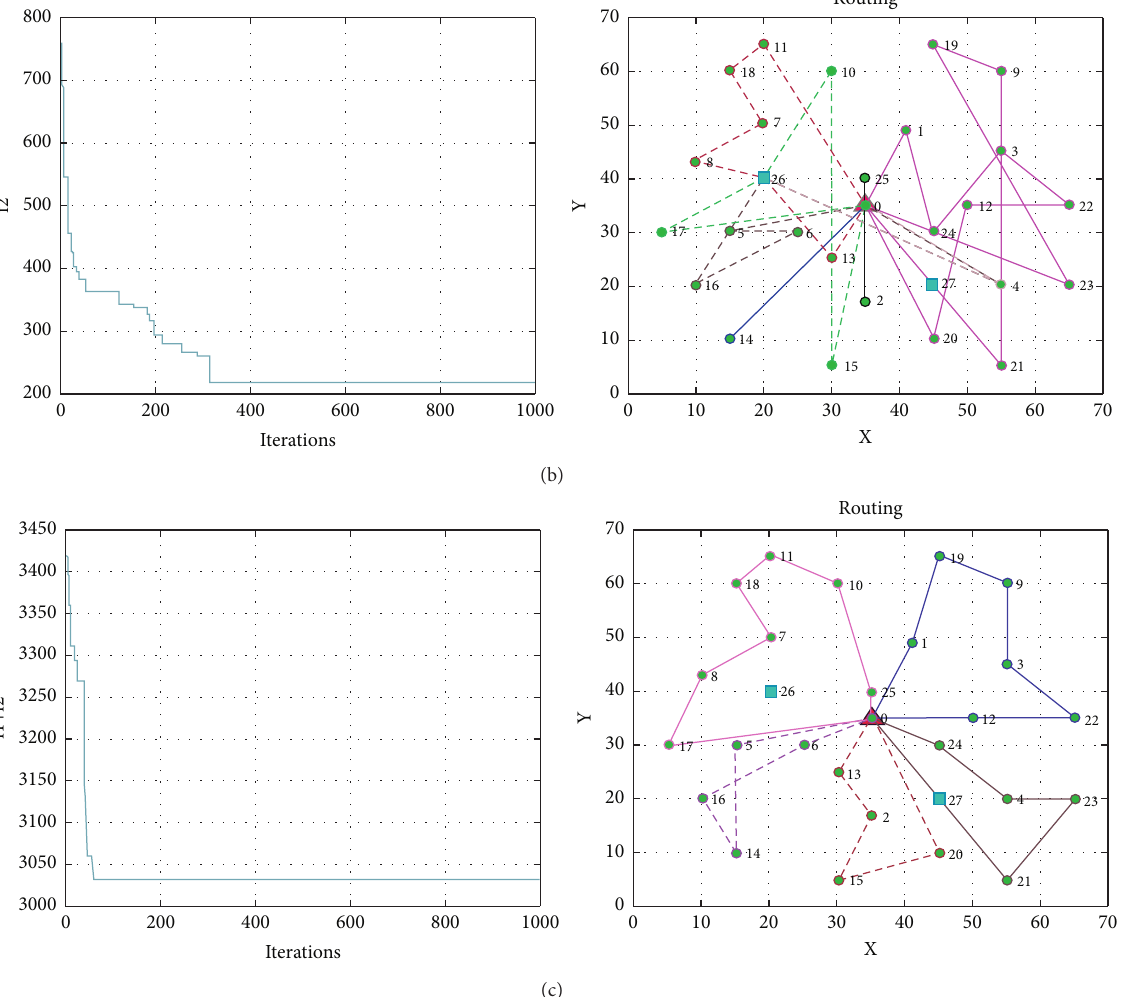
. (b) The results when only optimizing 1